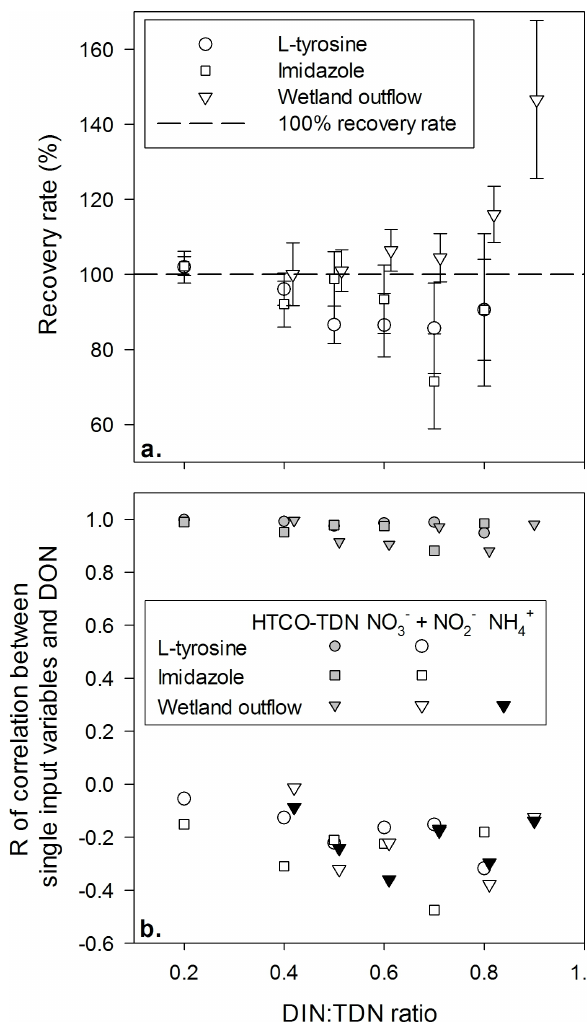
Fig. 2. Effect of NO − enrichment on the recovery rate of DON 3 (mean ± 1SD of 6 measurement replicates) determined by MC sim- ulations for the standard approach (a) and results from the sensi- tivity analysis of the MC simulations (b) . Correlation coefficients ( R = Pearson r ) are given for correlations between the variability of the input variables and the variability of the calculated DON con- centration. Please see Table 1 for further details on the